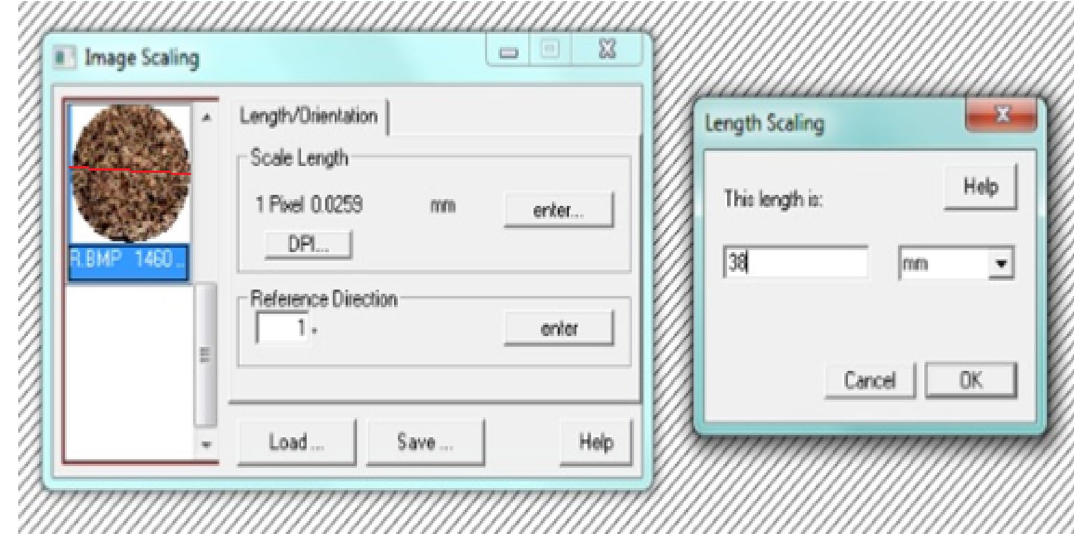
Fig. 2 Image scaling definition (Zafari